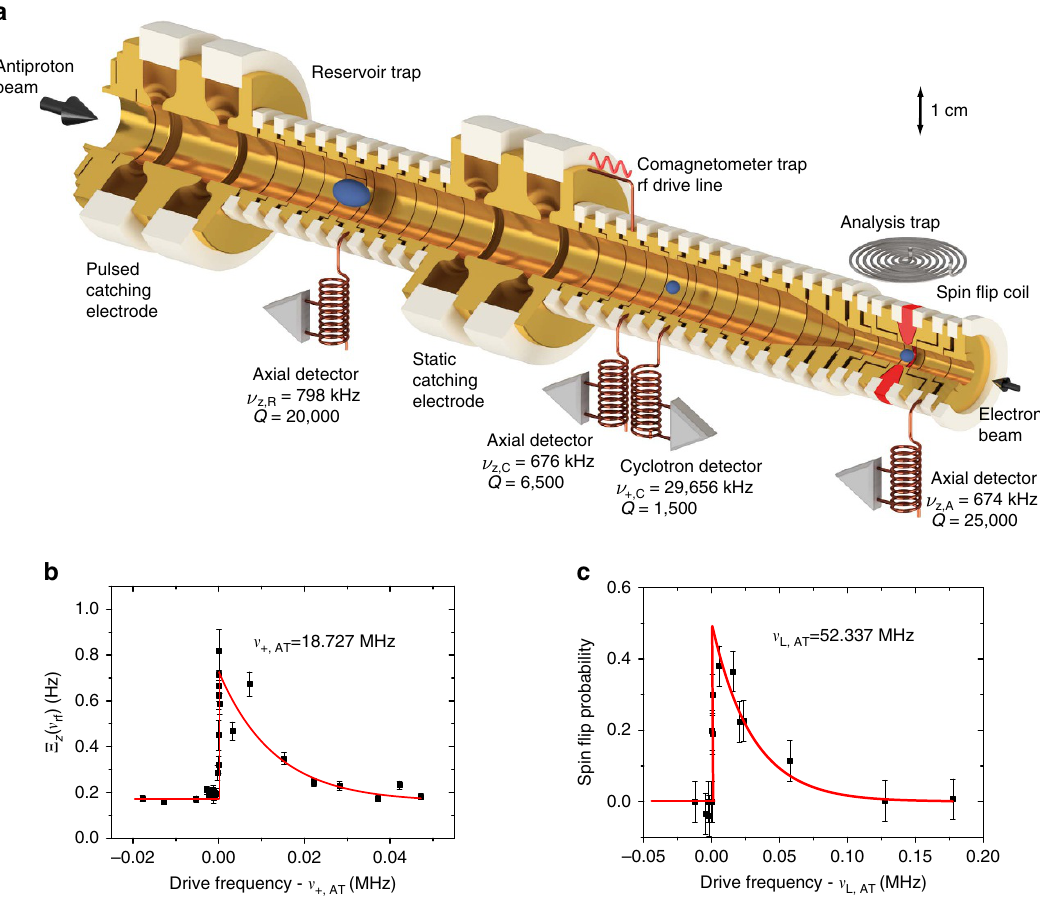
Figure 1 | Experimental set-up and resonances. ( a ) Schematic of the Penning trap set-up used in the BASE experiment. A cloud of antiprotons is stored in the RT, which supplies single particles to the CT and the AT when required. The CT is used for continuous magnetic field measurements. The AT is the trap with the strong superimposed magnetic bottle, which is used to measure the cyclotron frequency and the Larmor frequency. All traps are equipped with radio-frequency excitation electronics and highly sensitive superconducting detection systems. ( b ) Cyclotron and ( c ) Larmor resonance curves, both measured in the AT. The error bars in ( b , c ) represent the standard deviations of the individual